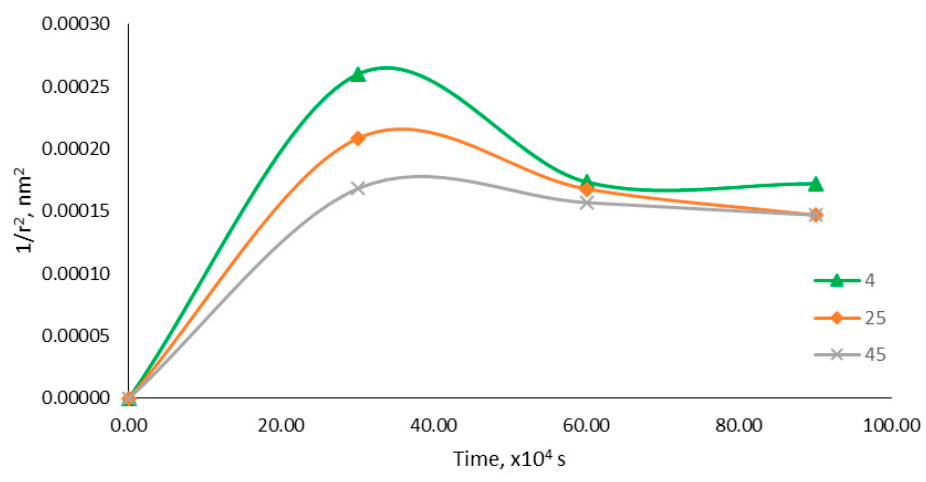
Figure 5. Graph of 1 / r 2 versus storage time (s).